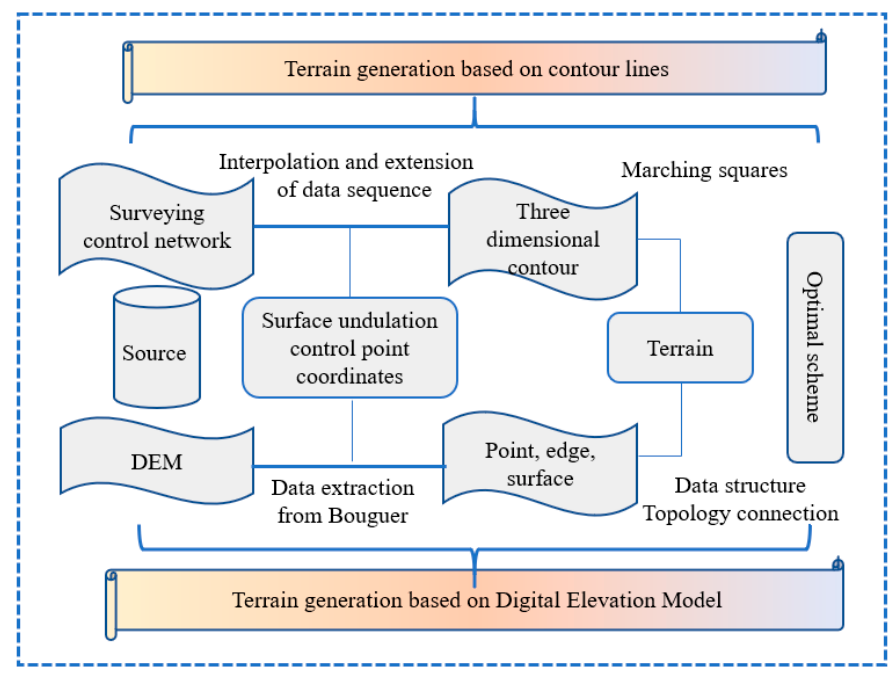
Figure 4. Diagram of two terrain modeling methods.